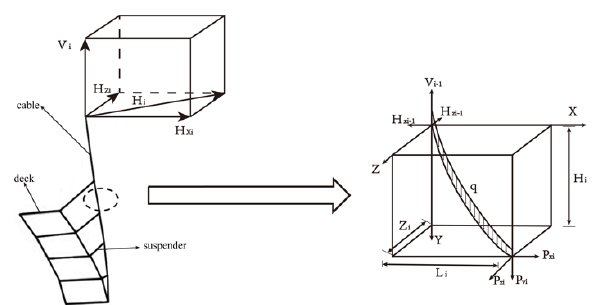
Figure 1. Calculation Diagram of Main Cable of Single Cable Plane Curved Suspension Bridge [11].